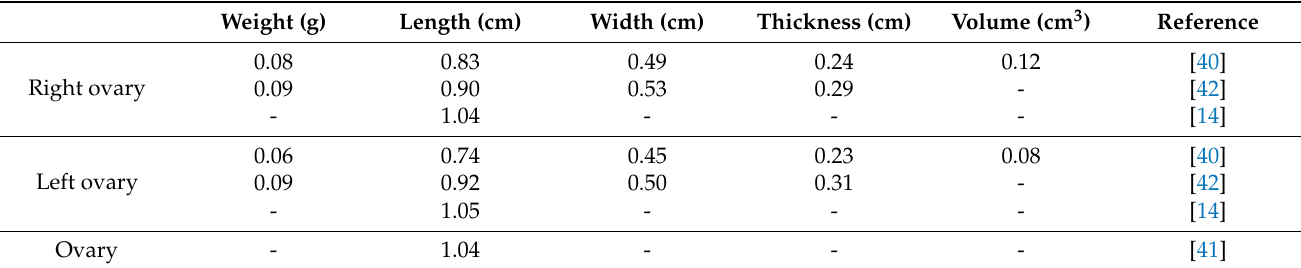
Table 1. Average morphometric data of the agouti’s